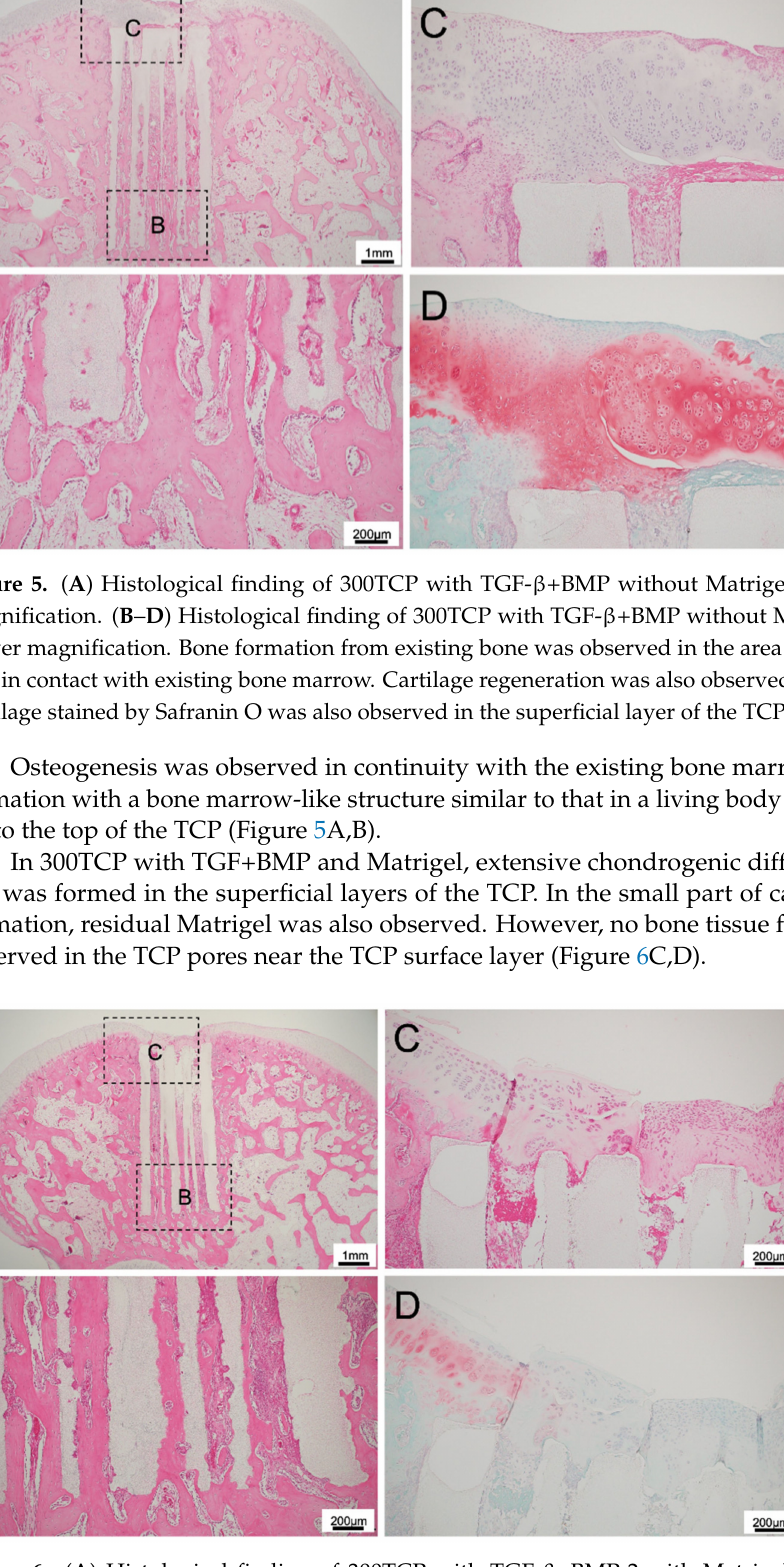
Figure 6. ( A ) Histological finding of 300TCP with TGF- β +BMP-2 with Matrigel at low power magnification. ( B – D ) Histological finding of 300TCP with TGF- β +BMP-2 with Matrigel at high power magnification. Bone formation from existing bone was observed in the area where the TCP was in contact with existing bone marrow. Cartilage regeneration as stained by Safranin O was also observed in the superficial layer of the